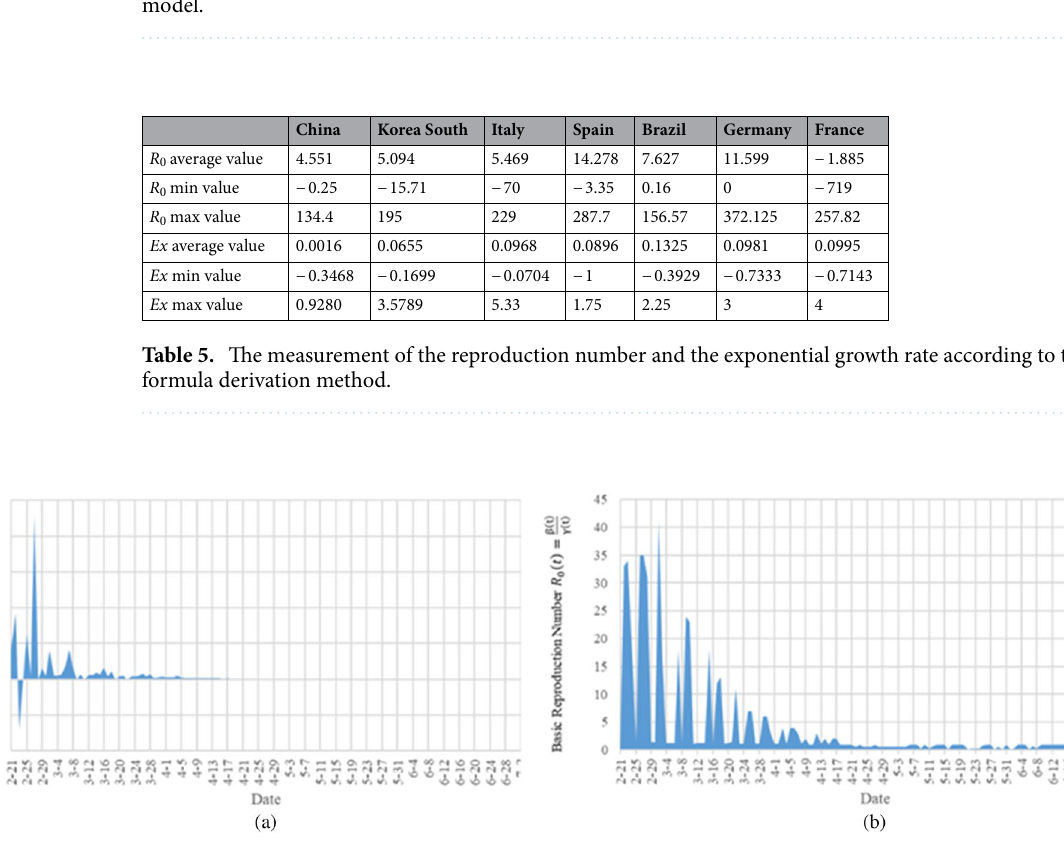
Figure 3. Basic reproduction number R 0 ( t ) in